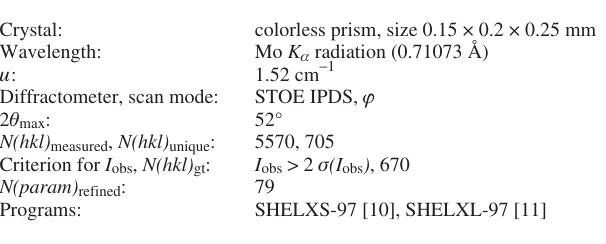
Table 1. Data collection and handling.